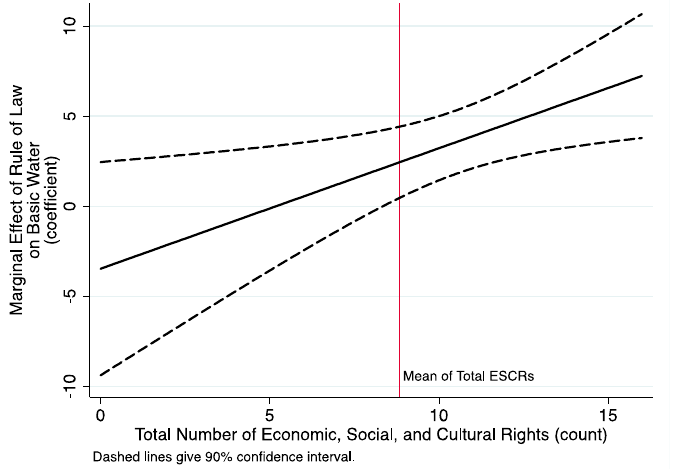
Figure 1. Marginal Effects of Rule of Law and ESCRs on Access.